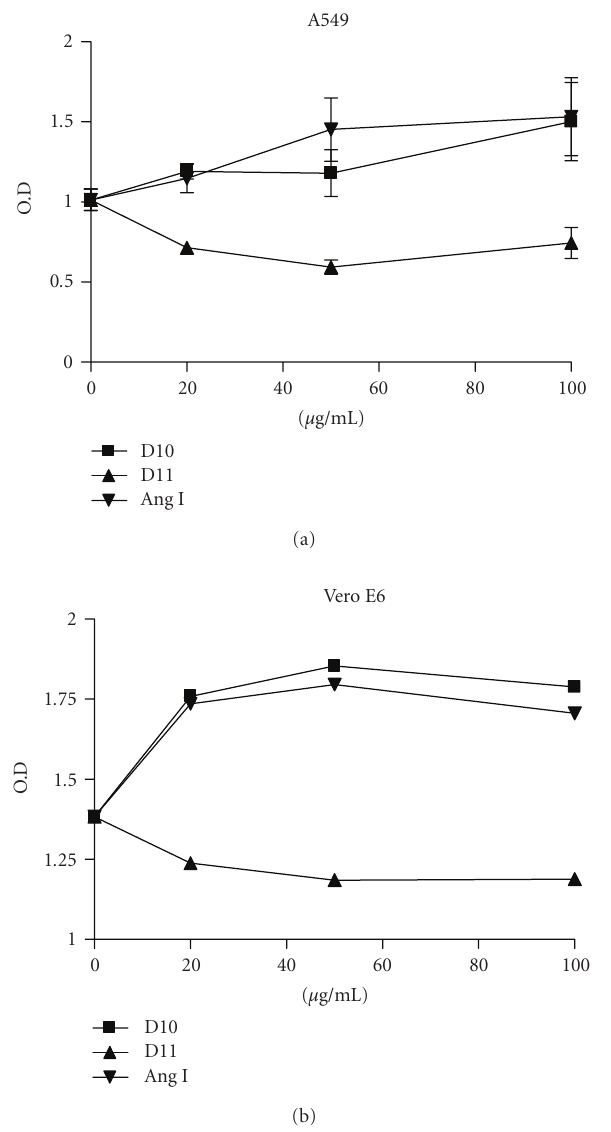
Figure 7: Cell proliferation induced by D10 peptide and Ang I. Vero and A549 cells were incubated with di ff erent doses of peptides as in- dicated. Cell proliferation was detected after 72 hours of incubation by XTT assay as described in Section 2. Data represents the mean ± SD of triplicates.